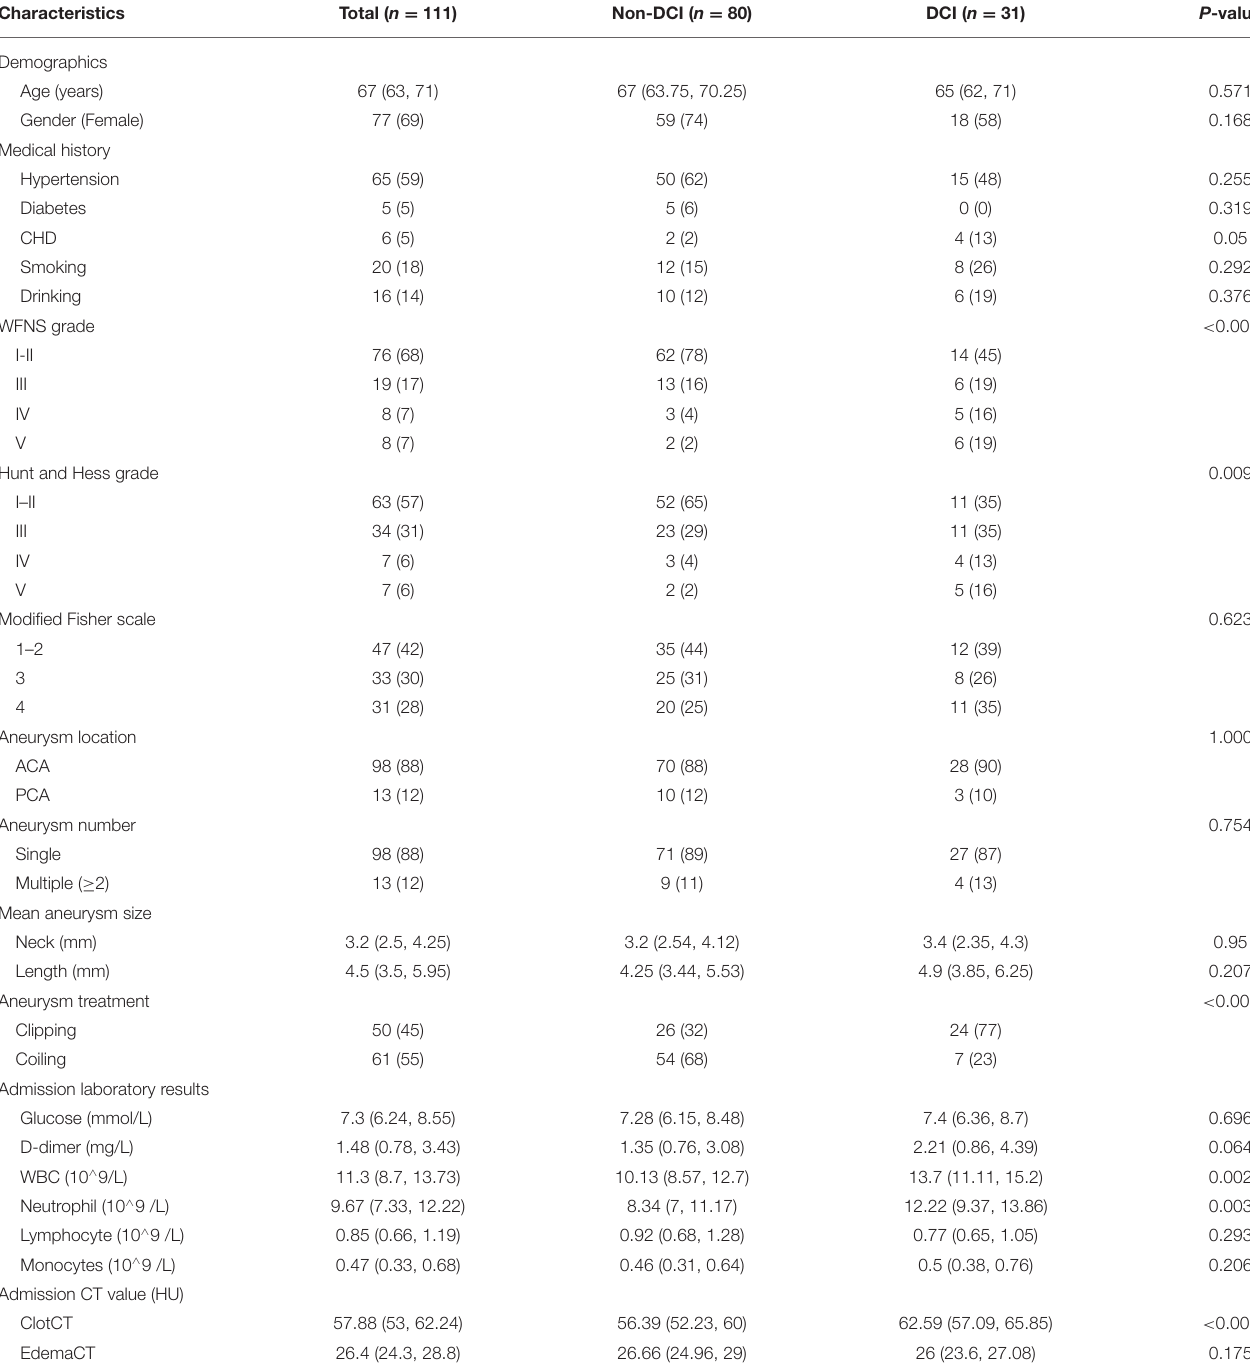
TABLE 2 | Baseline characteristics of model training cohort based on delayed cerebral ischemia.